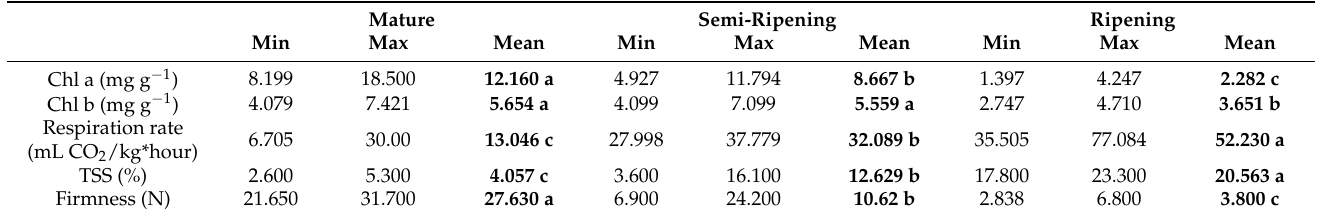
Table 2. Variation in the values of fruit quality parameters under different ripening